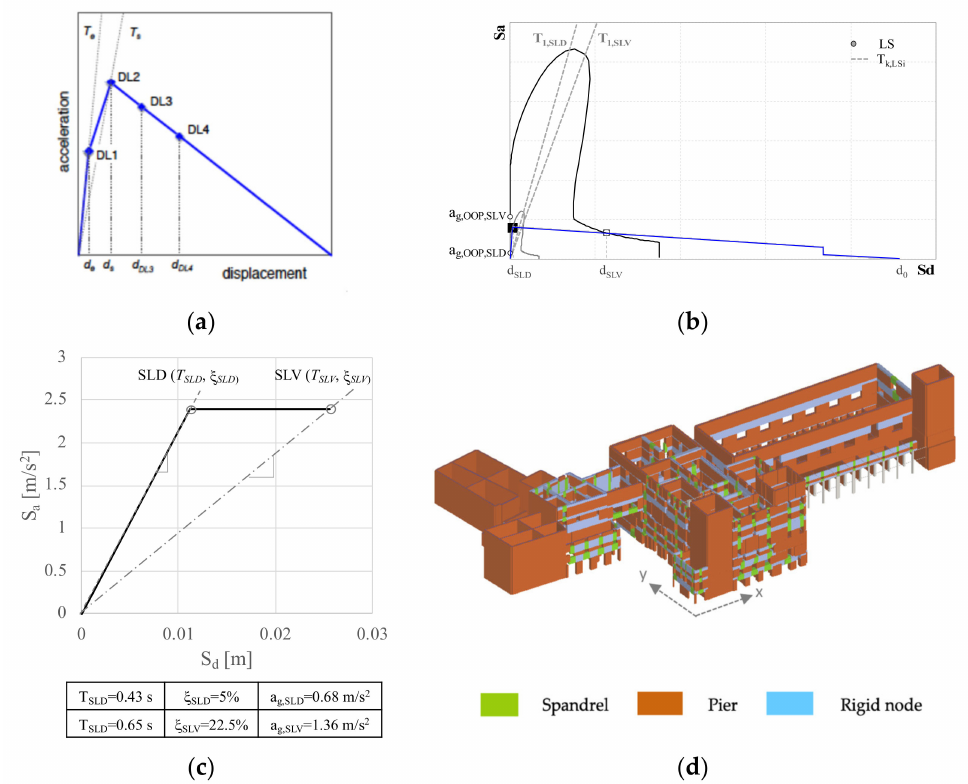
Figure 5. ( a ) Capacity curve of the local mechanism and LS definition; ( b ) floor spectra evaluation and seismic assessment—figures adapted from [32]; ( c ) value of T LSi and ξ LSi considered for the floor spectra definition as defined on the bi-linear curve of the global model; ( d ) 3D view of the global SEM model (see Section 4 for more